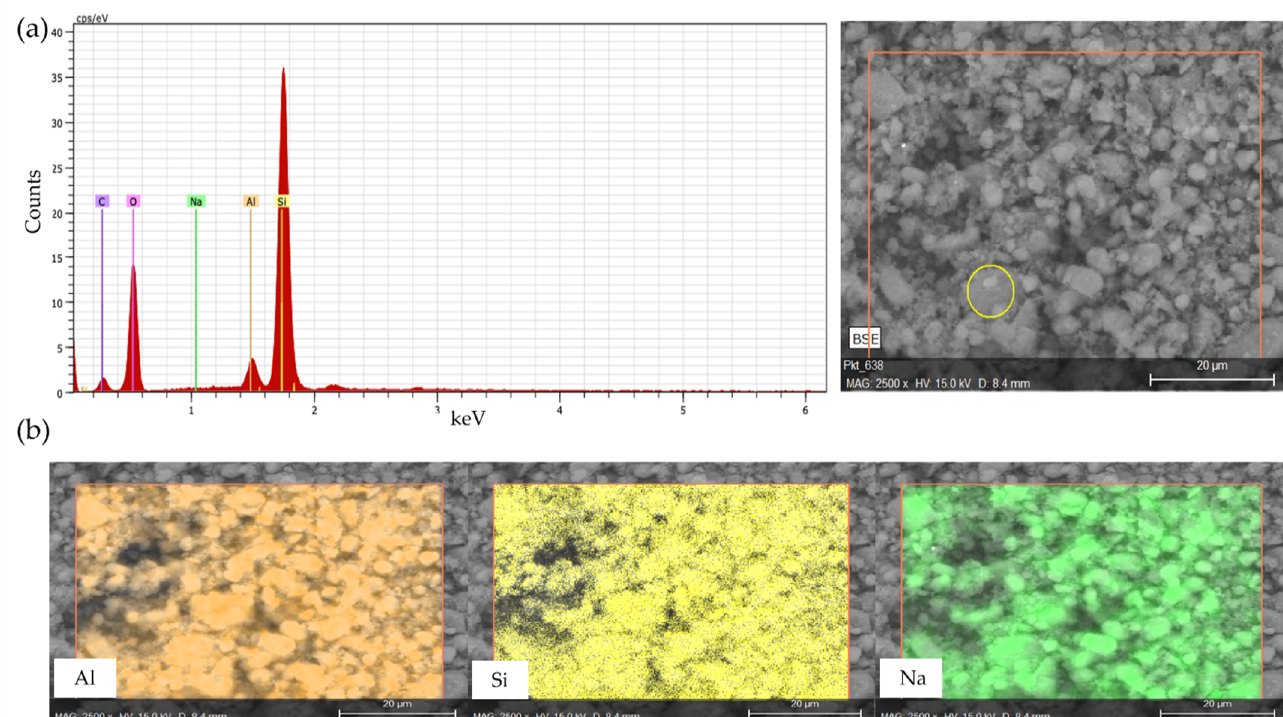
Figure 5. SEM for Na-BEA zeolite with EDS analysis ( a ) and distribution of Al, Si and Na in Na-BEA zeolite ( b ).